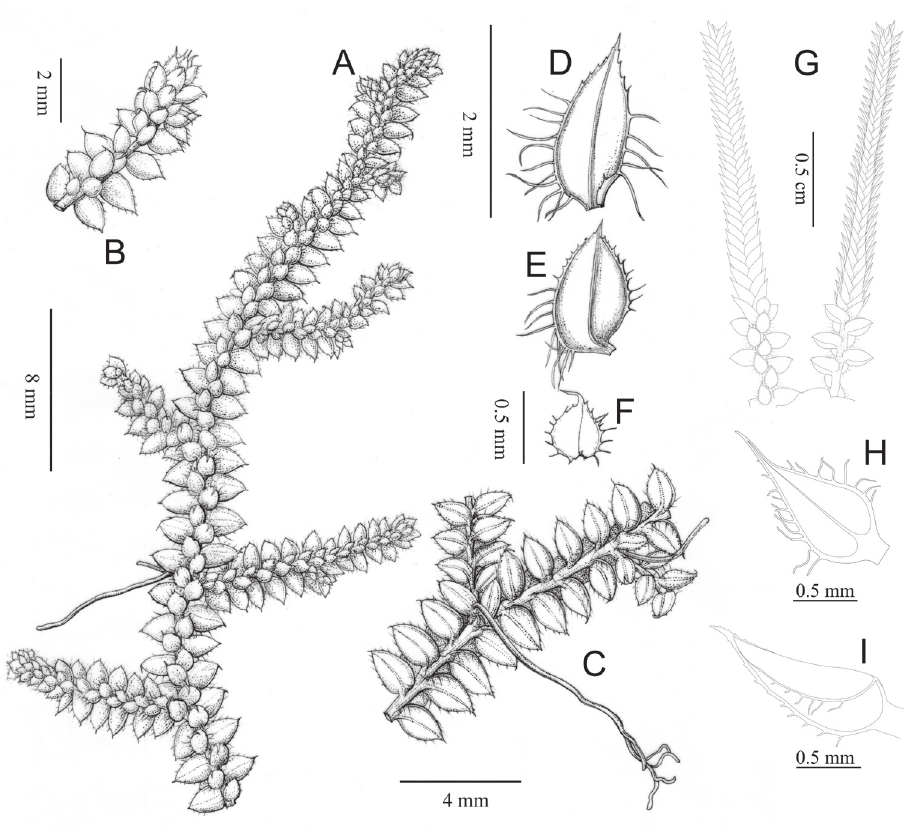
Figure 3. Illustration of Selaginella wuyishanensis A habit B adaxial view of branch C abaxial view of branch with rhizophore D axillary leaf E ventral leaf F dorsal leaf G strobili H ventral sporophyll I dor- sal sporophyll ( A–F drawn by Sun YB based on the isotype at NF G–I drawn by Wei HJ based on the paratype at